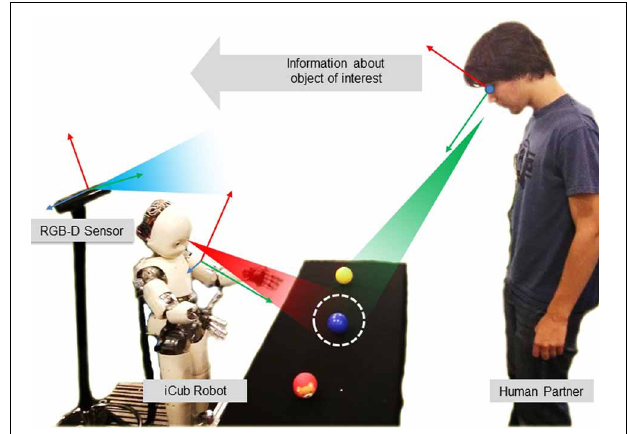
FIGURE 1 | The object learning experimental